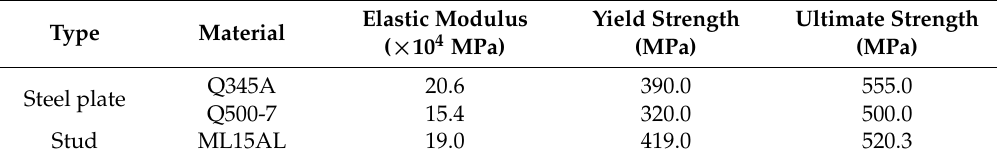
Table 4. Properties of the steel plate and studs.